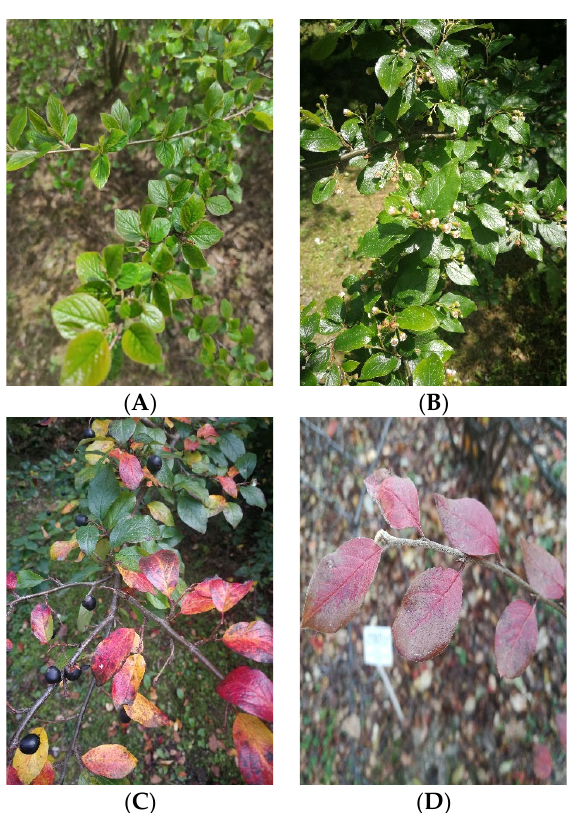
Figure 2. Photos of C. hissaricus under study were collected in ( A ) April, ( B ) May, ( C ) September, and ( D ) October.